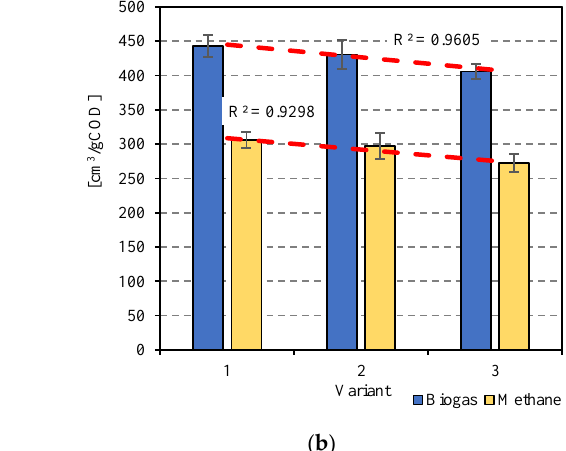
Figure 4. The course of the AD process ( a ) and correlations between OLRs applied and biogas and methane yields ( b ) achieved in S2.